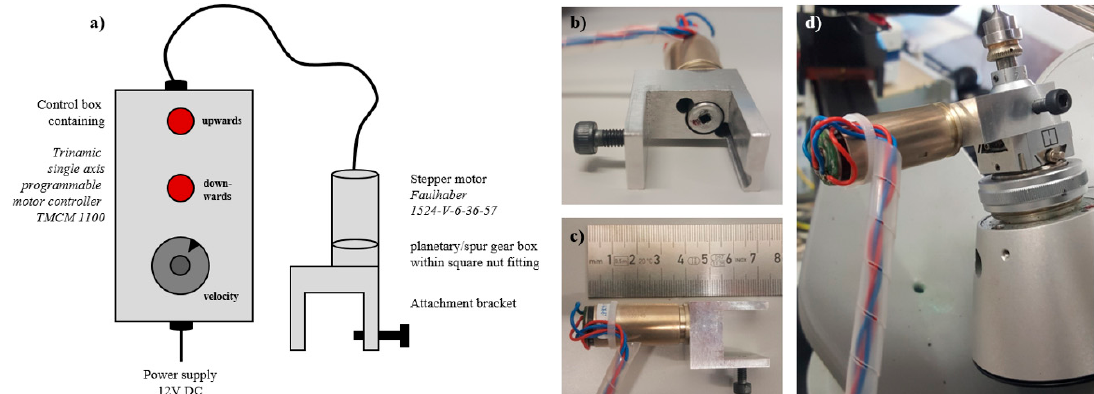
Figure 1. ( a ) Sketch of the attachment showing its main components, ( b ) front view of attachment bracket with square nut fitting, ( c ) side view and size relations of attachment, ( d ) device attached to a Huber goniometer head (model 1004) mounted on the φ -axis of a Mach-III four circle goniometer.